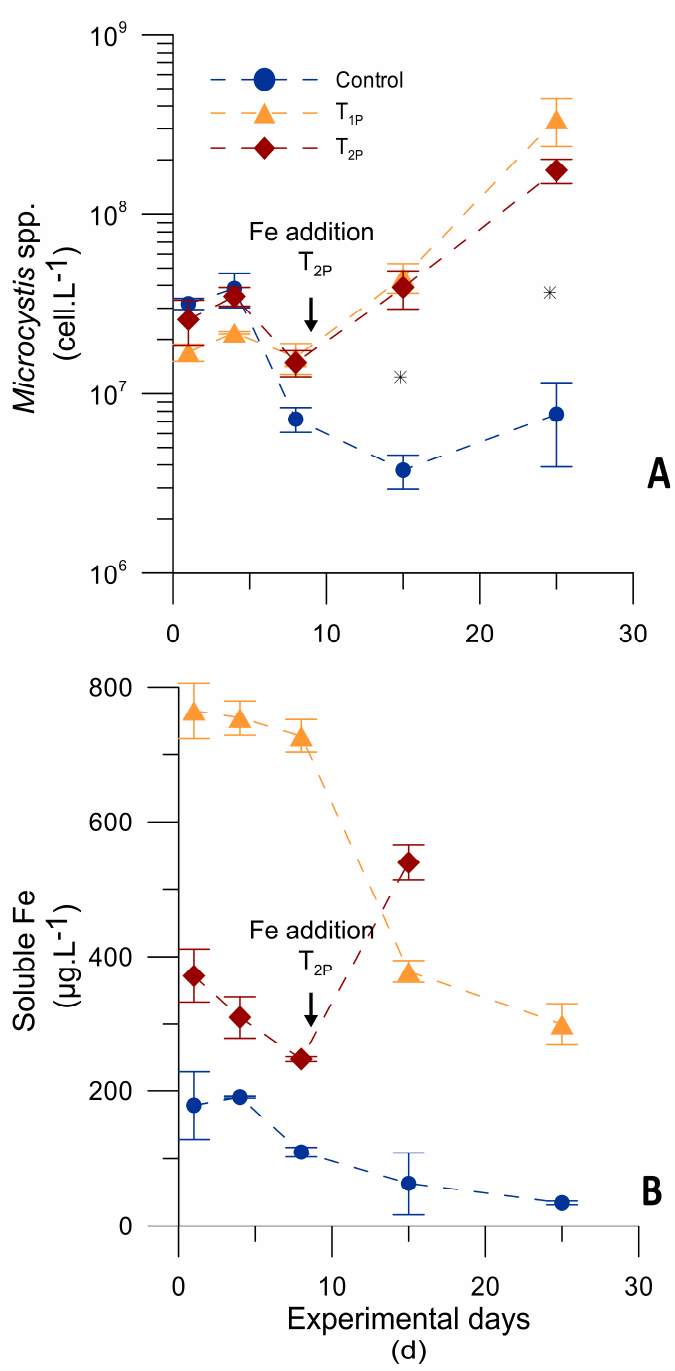
Figure 3. Cell abundance (cell·L −1 ) ( A ) and soluble iron concentration (SFe; µg·L −1 ) ( B ) in Microcystis spp. natural populations from sample-2018 under different treatments during the second experiment. Control, without iron addition (179 ± 25 µg Fe·L −1 ); T 1P , with a single pulse: +700 µg Fe·L −1 at day 1 (D1); T 2P , the same amount divided in 2: +350 µg Fe·L −1 at D1 (first pulse) and 350 µg Fe·L −1 at day 9 (second pulse). Values are the means of triplicates, and vertical lines above symbols represent standard deviations. The SFe content in T 2P is missing for day 25. Asterisks are located above the treatments that showed a significant difference in cell abundance in comparison with that in the other treatment groups ( A ).